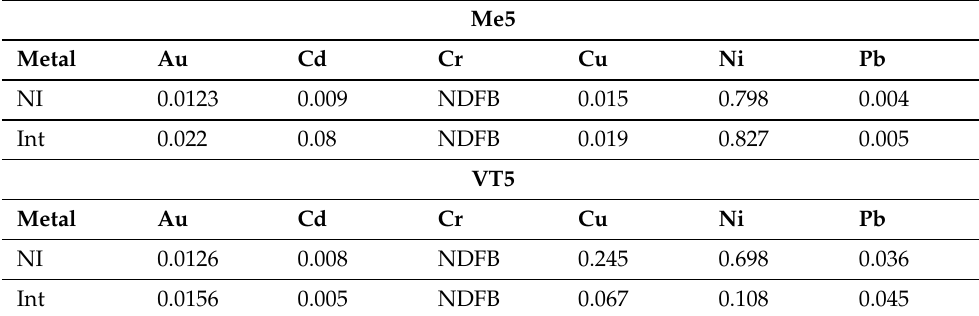
Table 7. Mass in ng per puff for Juul devices tested by Chen et al. [17], for 50 mg/mL nicotine concentration and Menthol and Virginia Tobacco flavors (Me5,VT5) and non-intense and intense regime (NI,Int). NDFB stands for Not Different From Blank.